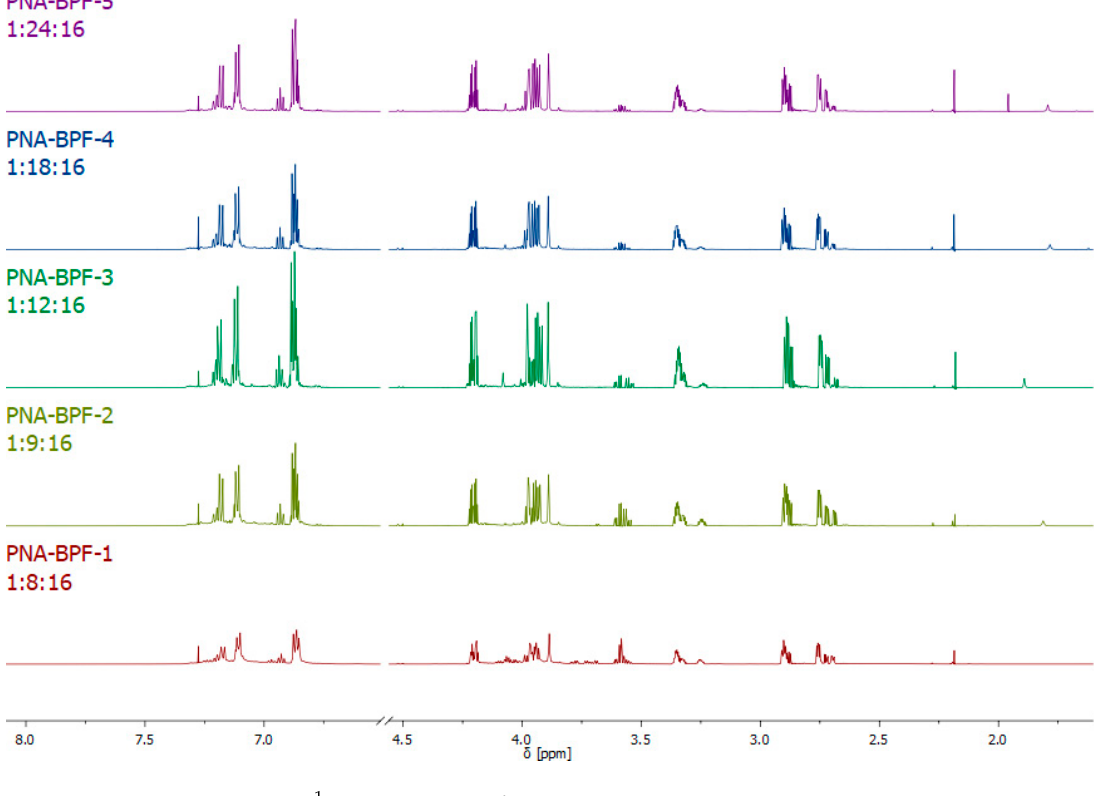
Figure 6. 1 H NMR spectra of PNA-BPF.